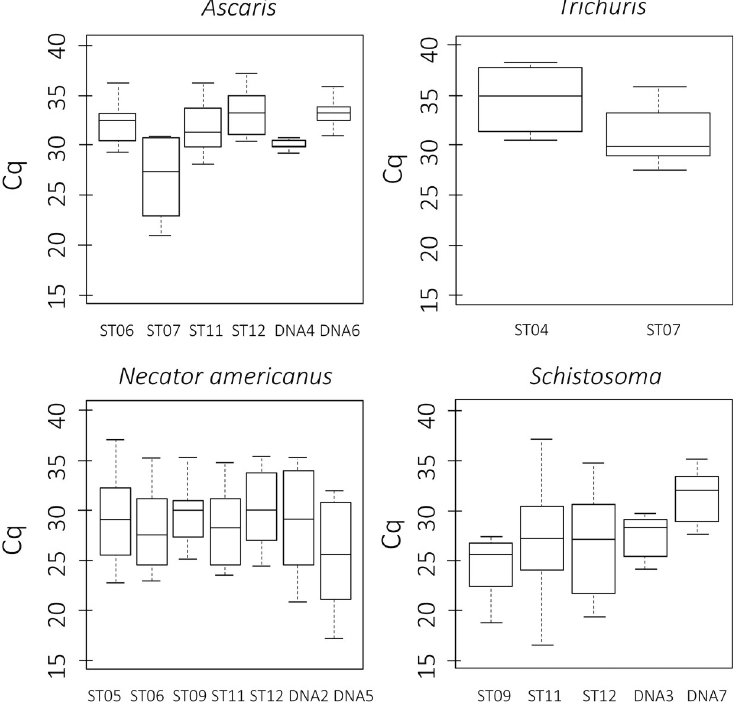
Fig 2. The variation in the reported Cq-values across the different targets and samples. The Cq-values reported by the different participants for the different targets is shown on the Y-axis. The boxes represent the interquartile range; the lines in the boxes represent the median values; the upper and lower whiskers represent the 95 th and the 5 th percentile, respectively; and the dots represent outliers. The X-axis represents the different samples of the HEMQAS panel (see Table 3